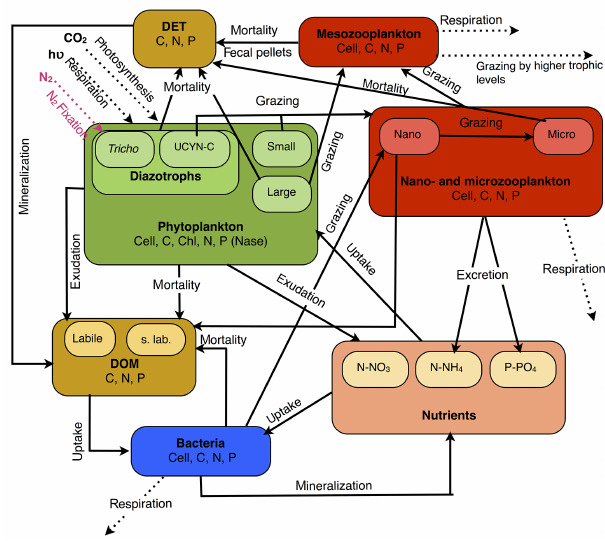
Figure 1. Conceptual diagram of the biogeochemical model for the 1-D vertical model used in the VAHINE